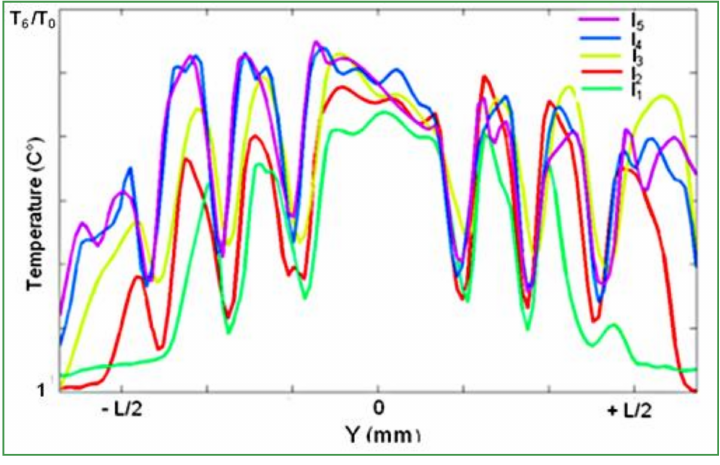
Figure 9. Temperature variation of the tire tread for a given velocity s 3 lower than 120 km/h, at a given skidding angle of 6 ◦ and for five different loadings: l 1 , l 2 = l.5 × l 1 , l 3 = 2 × l 2 , l 4 = 1.3 × l 3 , l 5 = 1.3 × l 4